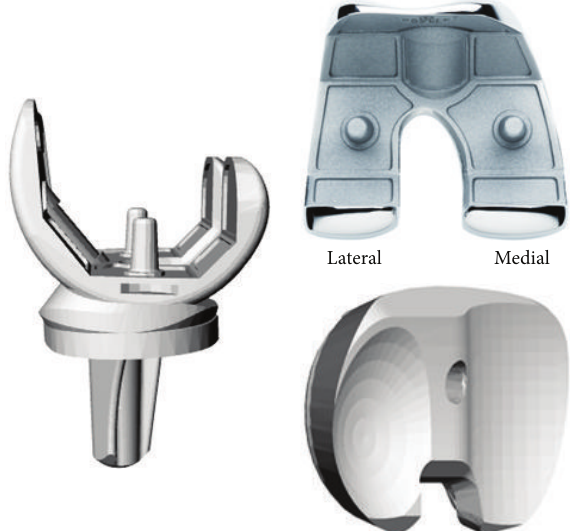
Figure 1: The 3D Knee is a fixed-bearing total knee prosthesis suitable for use in PCL-retained or PCL-resected